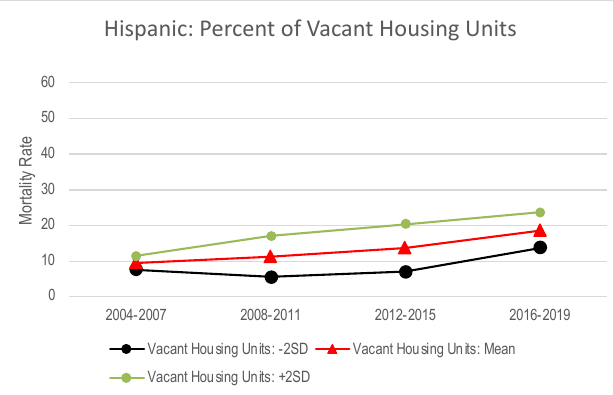
Figure 2. Predicted trajectories of county-level drug mortality rates with varying levels of percentage of county-level vacant housing units among Hispanic individuals: The Wide-Ranging Online Data for Epidemiologic Research, 2004–2019. Note: as shown in Tables 2–4, the trajectories of drug mortality rates were predicted, holding all other covariates within the model at their average value. Drug mortality rate indicates county-level crude drug mortality rates per 100,000 persons.